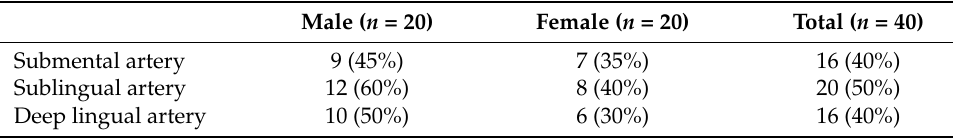
Table 3. Detectable rate.